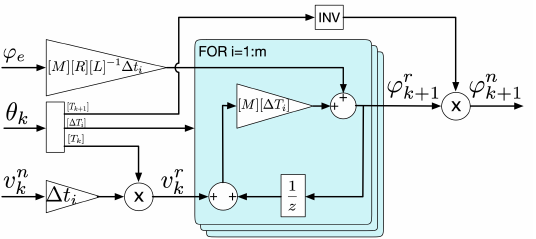
Figure A3. Discrete time model with rotor reference frame integration and PM flux: ROTOR-DSCR.